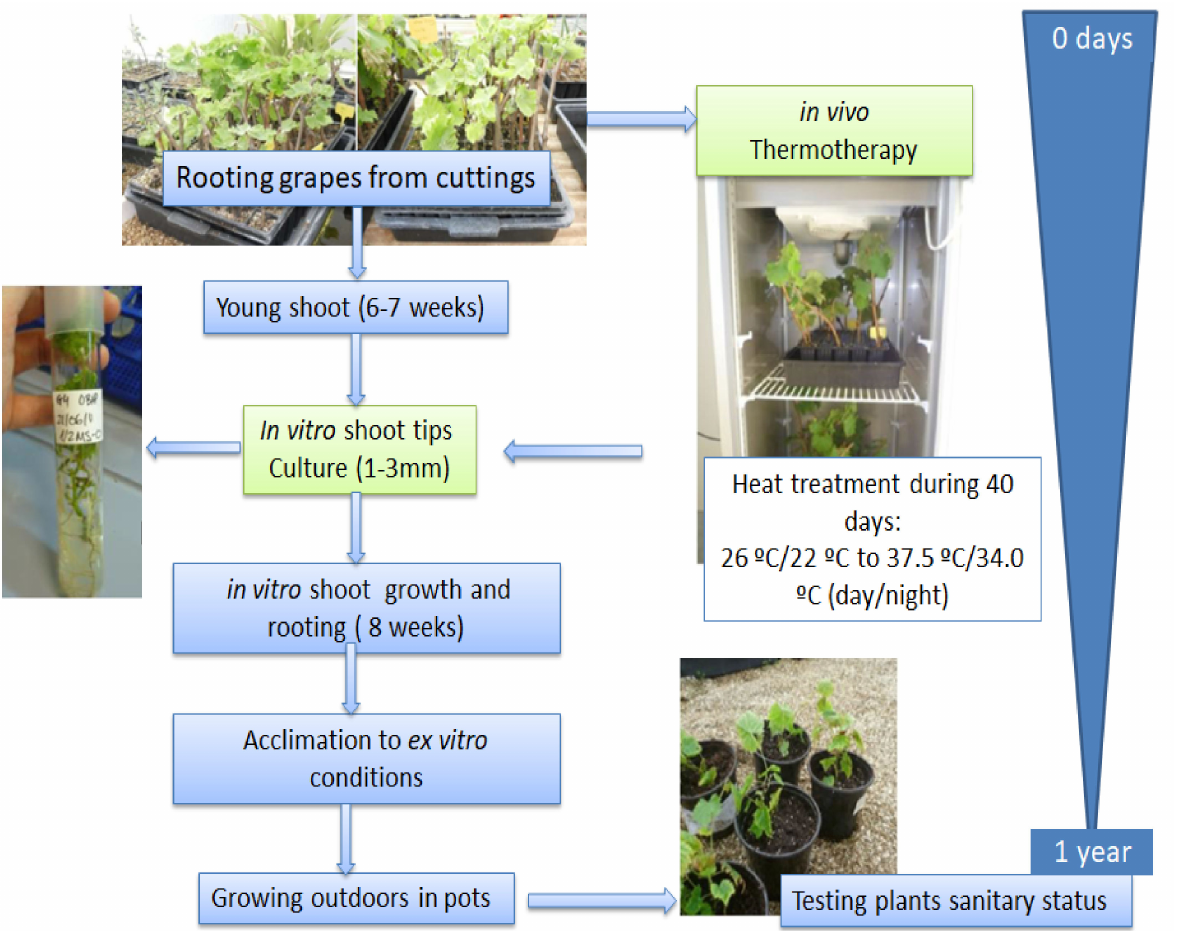
Figure 1. Sanitation procedures from the rooted cuttings to the greenhouse plants in two grapevines cultivars: Argamusa and